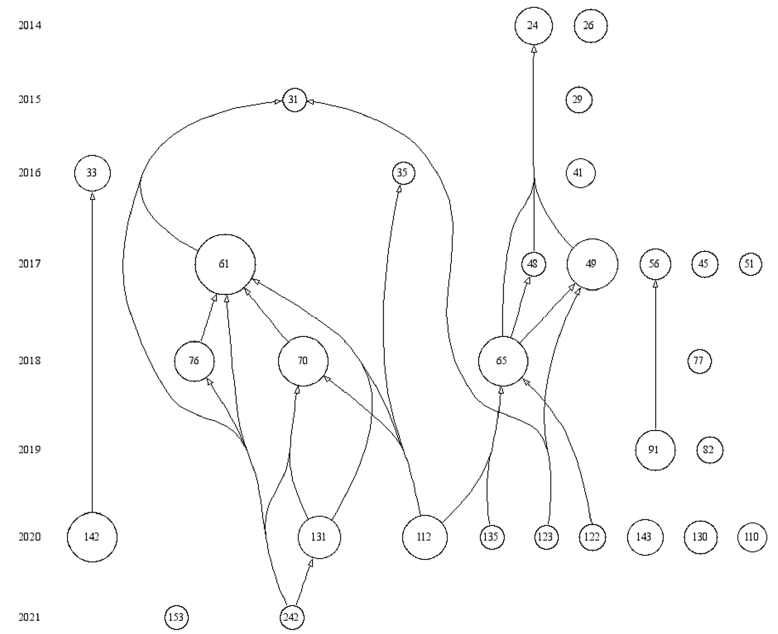
Figure 5. The top 30 publications highly cited by peers in the local database. Note: The number in the circle refers to the serial number of the document in the local Table 5. Details of the top peer ‐ cited papers in the local database.